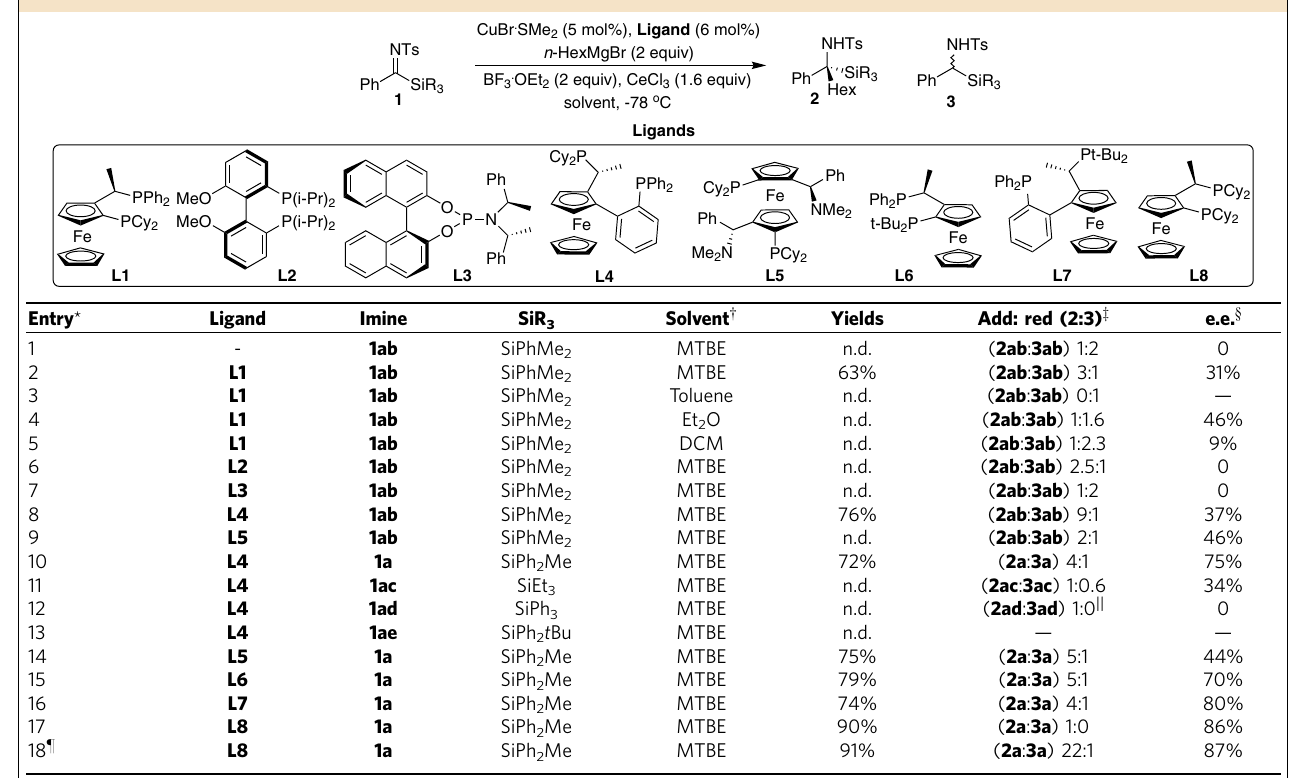
Table 1 | Catalytic asymmetric alkylation of silyl ketimines: selected optimization